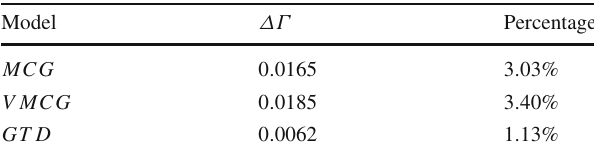
Table 3 Discrepancies with respect to previous Chaplygin models. We considered, in particular, the modified version of the Chapygin gas, namely MCG , the variable modified Chaplygin gas V MCG and our model, here indicated as GT D . The percentages reported on the right side of the table are defined by ΔΓ/γ Λ CDM . They represent the per- centage discrepancies among the various models. The values of γ i for the modified and variable modified Chaplygin gas have been taken from [51]